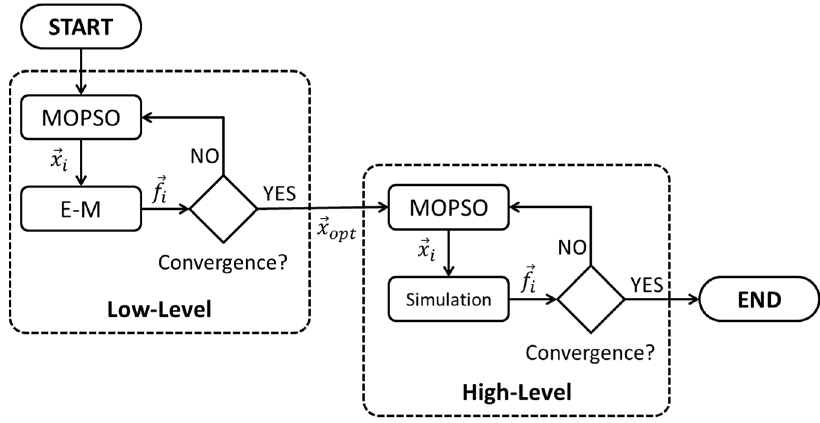
Figure 9. Flowchart of the proposed two-level optimization scheme.